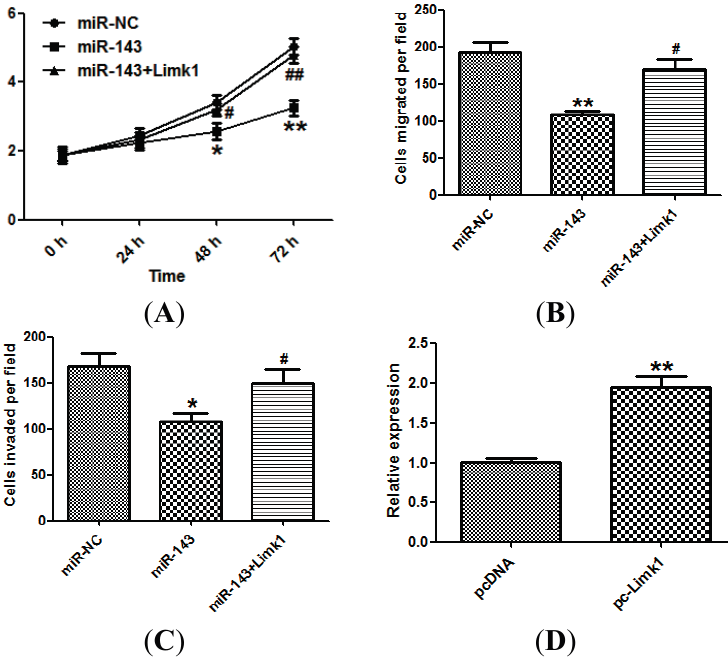
Figure 5. miR-143 suppresses NSCLC development by targeting Limk1. ( A ) NCI-H23 cells were transfected with miR-143 with/without Limk1 overexpression plasmid (pcDNA-Limk1), and CCK-8 assay was performed; ( B ) Migration and ( C ) invasion assays of NCI-H23 cells; and ( D ) The expression of Limk1 of cells transfected with pcDNA-Limk1 or control vector was detected by qRT-PCR. The data represented three independent experiments. Experiments were performed in triplicate. * p < 0.05, ** p < 0.01 compared with control; # p < 0.05, ## p < 0.01 compared with miR-143 transfected group.